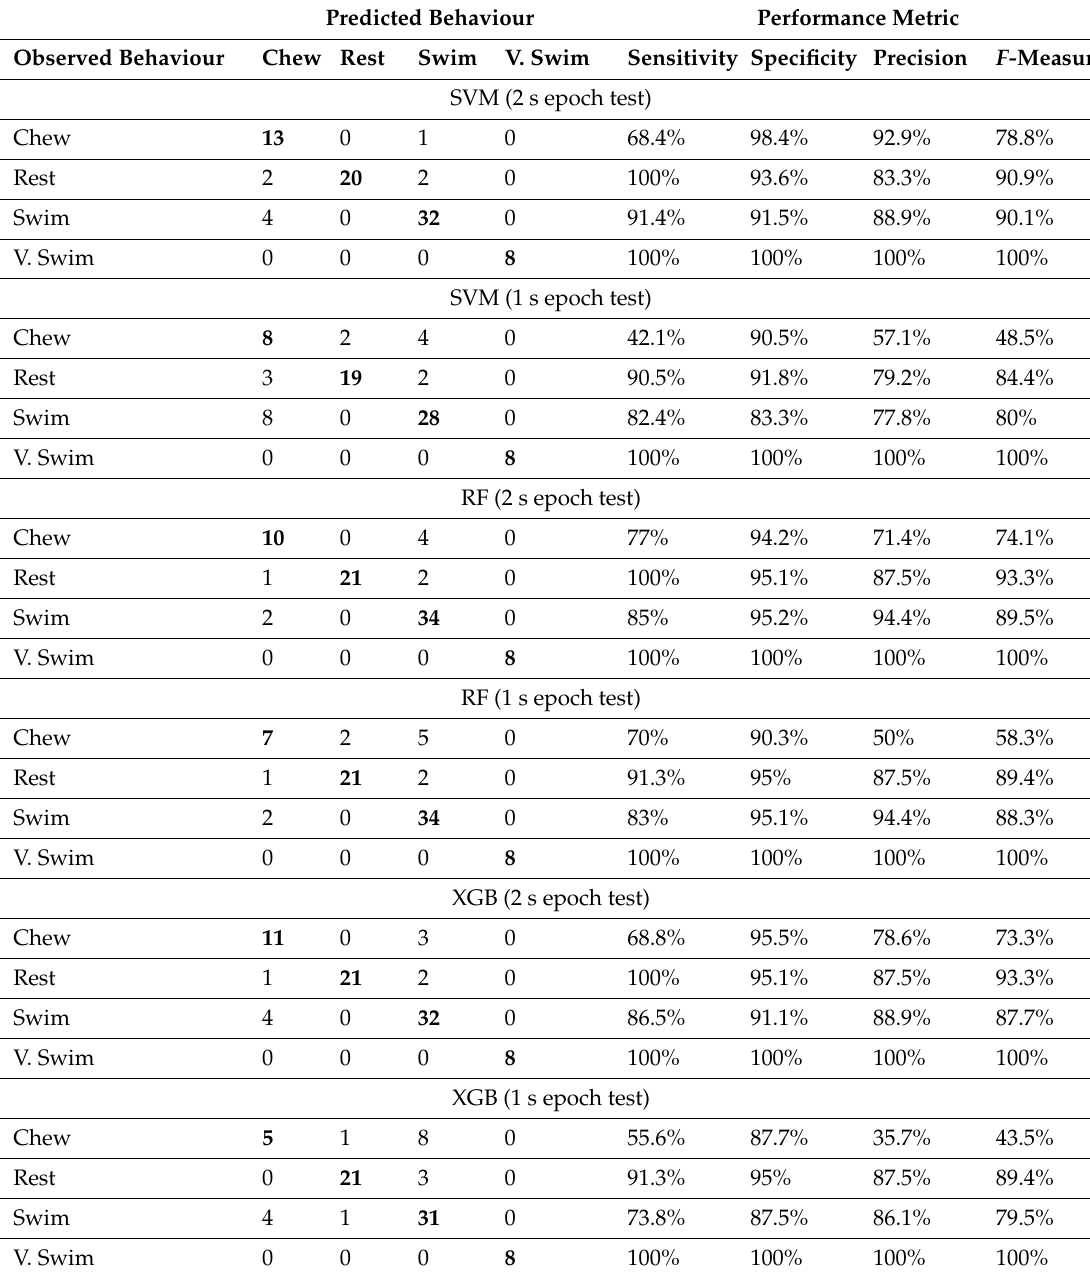
Table 6. Confusion matrix for the test set of the summarised data. Values in bold are correctly classified behaviour events. V. Swim is vertical swimming